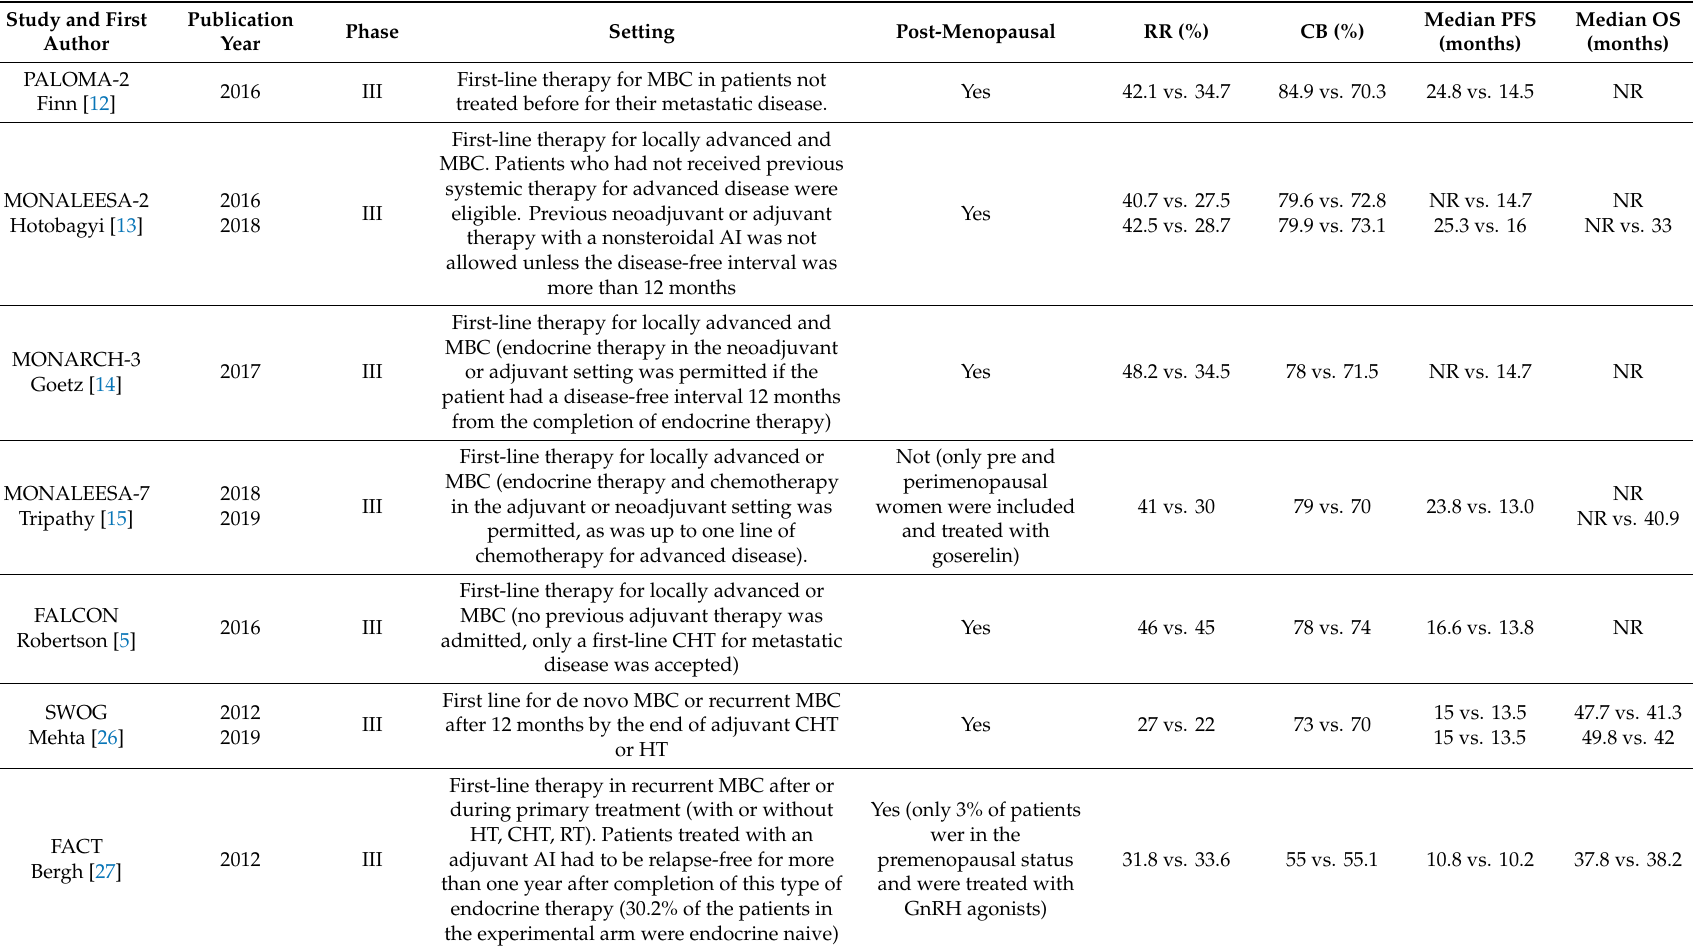
Table 1. Main characteristics and outcomes of the seven eligible trials included for